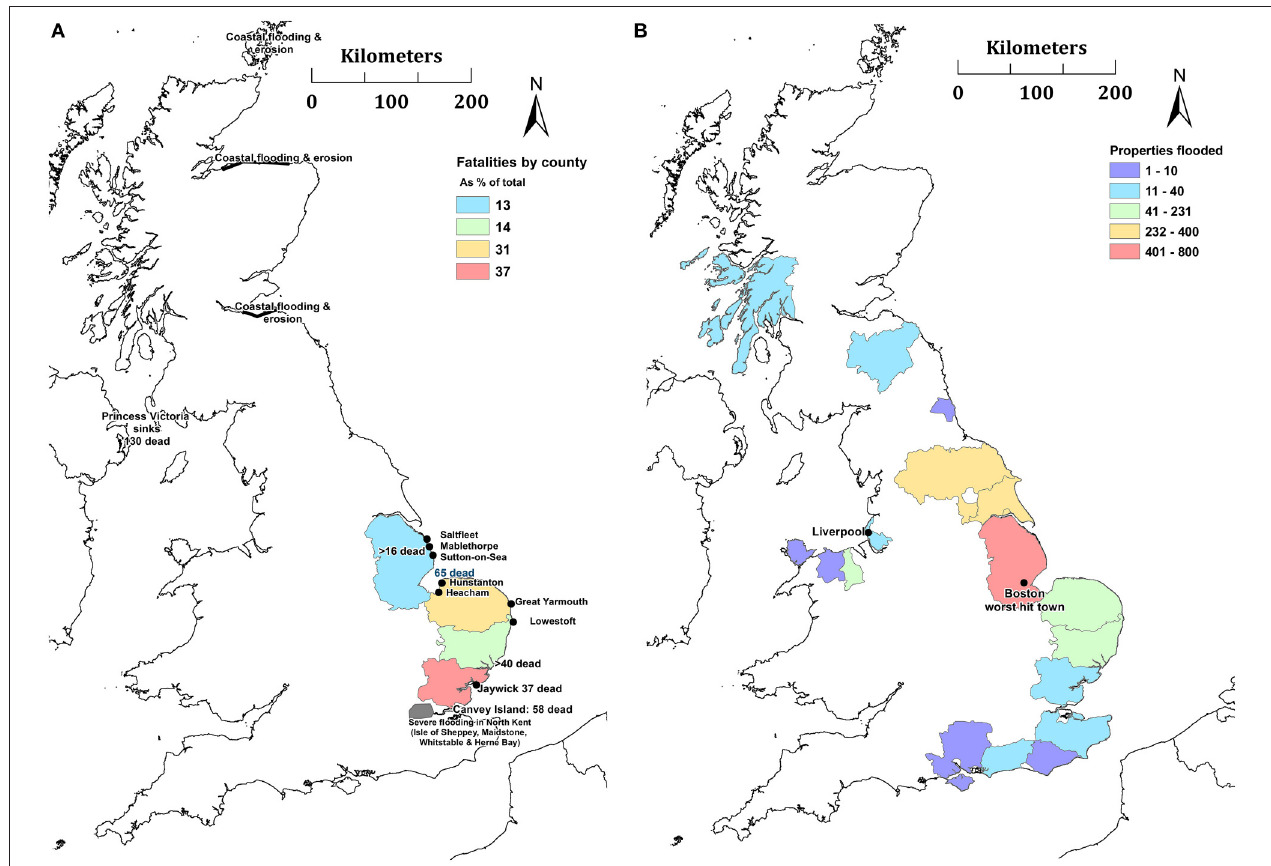
FIGURE 6 | (A) Summary of the main impacts of 1953—based upon human fatalities. Fuller summaries can be found in Steers (1953), Baxter (2005), and Hickey (2001) . (B) Summary of the main impacts of 2013, based upon properties affected by